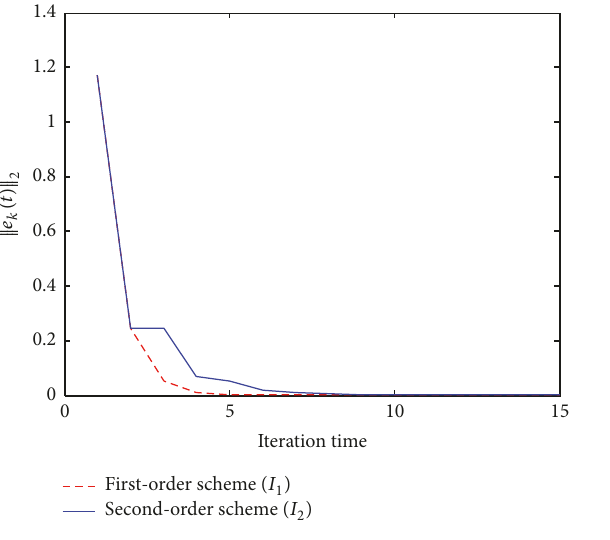
Figure 4: Comparison of tracking errors.